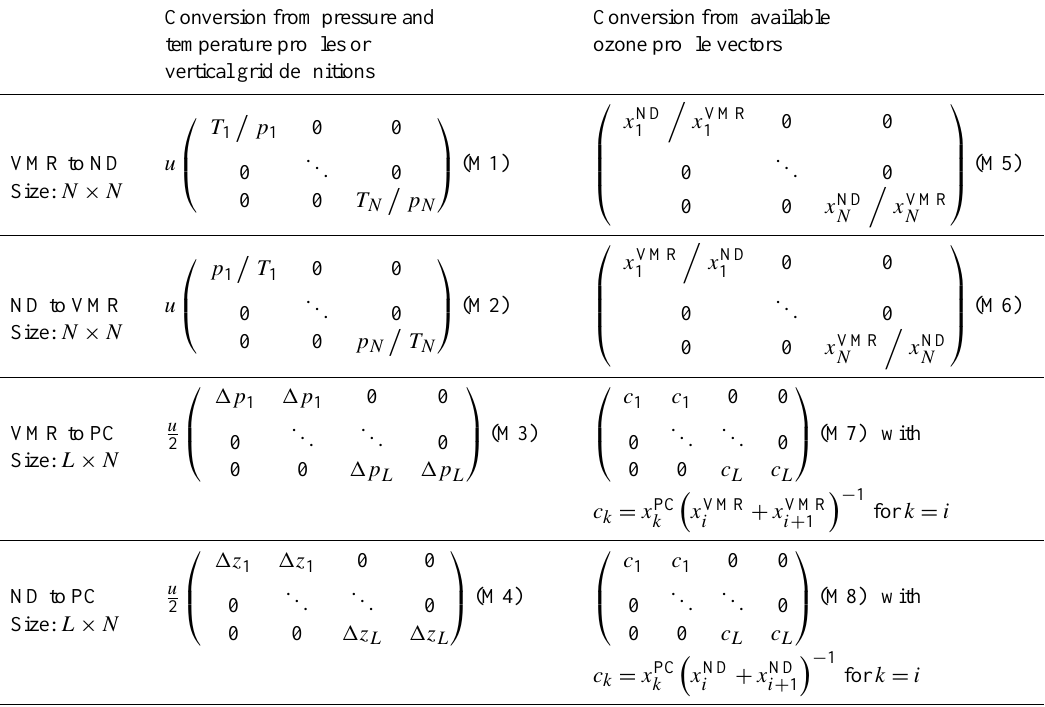
Table B1. Conversion matrix definitions for various unit conversions (rows) and for two possibilities regarding conversion factor construction (columns). The number of rows or columns always equals the number of retrieval levels N or the number of intermediate layers L = N − 1. The abbreviations VMR, ND, and PC stand for volume mixing ratio, number density and partial column, respectively. u represents a conversion constant depending on the units to be